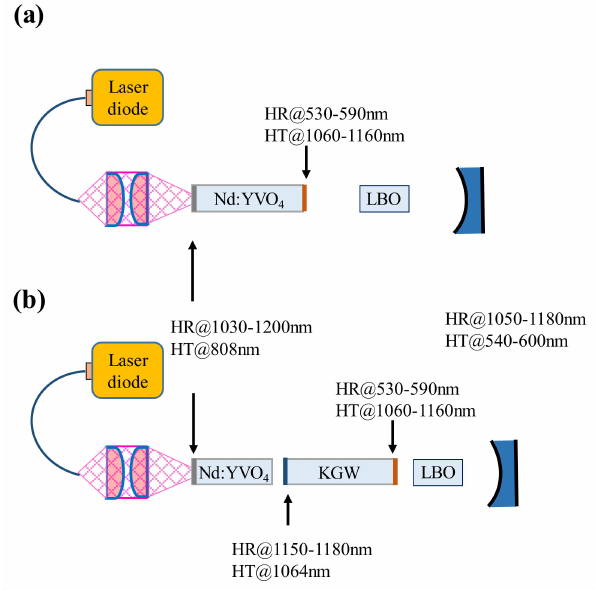
Figure 1. Experimental setup of the diode-pumped ( a ) self-Raman Nd:YVO 4 lasers and ( b ) Nd:YVO 4 /KGW Raman lasers with intracavity SFG and SHG for accomplishing the lime and orange wavelengths.